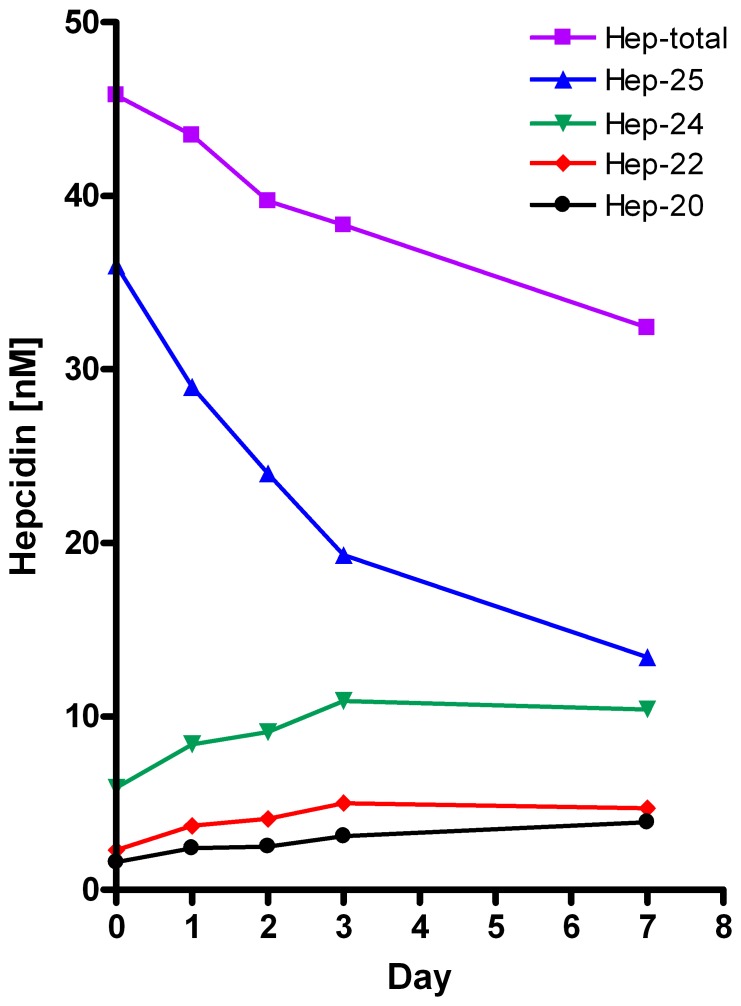
Changes in time at RT of hepcidin-25, 24, 22, and 20 and their sum (total hepcidin) in a representative heparin sample of an IC patient to illustrate that decrease in hepcidin-25 levels is accompanied by an increase in hepcidin-24, -22, and -20 levels.Similar observations for an extended set of samples are shown in Figure S1. Note that the total amount of hepcidin decreases despite the increase in hepcidin isoform levels.